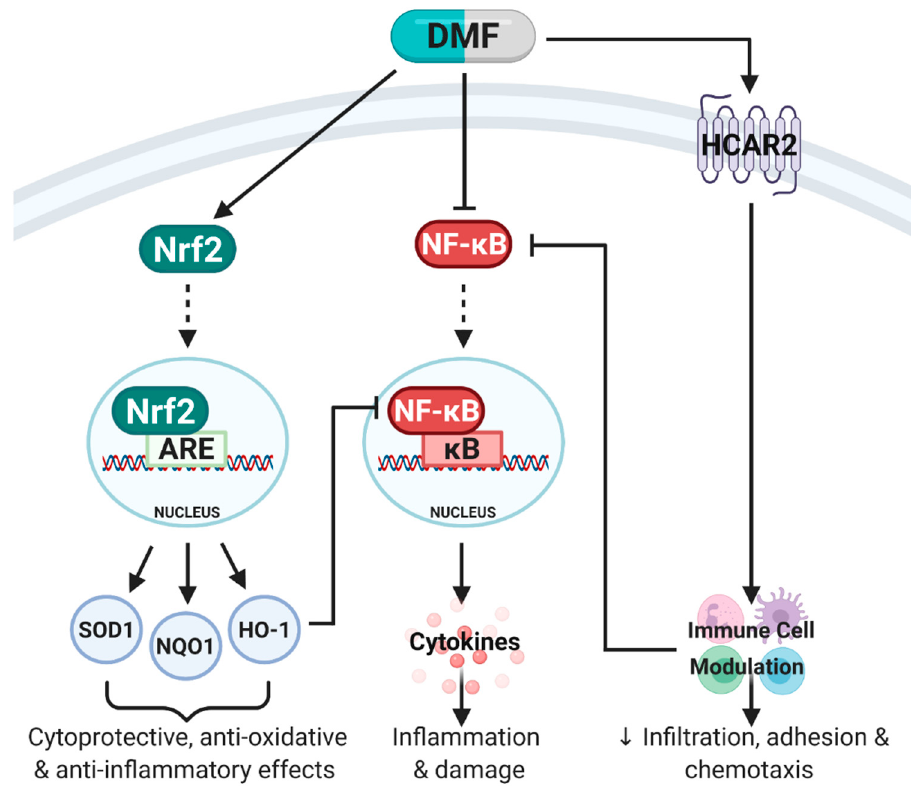
Figure 2. Simplified schematic of pathways activated by dimethyl fumarate (DMF). DMF is known to mediate its anti-inflammatory, anti-oxidative and immunomodulatory effects primarily through three molecular pathways: (1) Activation of nuclear factor erythroid 2-related factor 2 (Nrf2) which binds to the antioxidant response element (ARE) in the nucleus to stimulate transcription of Phase II enzymes including superoxide dismutase (SOD1), NAD(P)H quinone oxidoreductase-1 (NQO1) and heme oxygenase-1 (HO-1). Together, SOD1, NQO1 and HO-1 mediate cytoprotective, anti-oxidative and anti-inflammatory effects. (2) DMF can directly inhibit nuclear factor kappa B (NF- κ B), which prevents the translocation of NF- κ B into the nucleus, binding to the κ B site, release of pro-inflammatory cytokines and subsequent inflammation and damage. DMF can also indirectly inhibit NF- κ B through HO-1 expression and immune cell modulation through hydroxycarboxylic acid receptor 2 (HCAR2) activation. (3) DMF’s immunomodulatory effects are predominantly mediated through HCAR2 activation which modulates immune cell populations (pro-inflammatory to anti-inflammatory shift) and inhibits NF- κ B. Adapted from [7]. Created with BioRender.com.